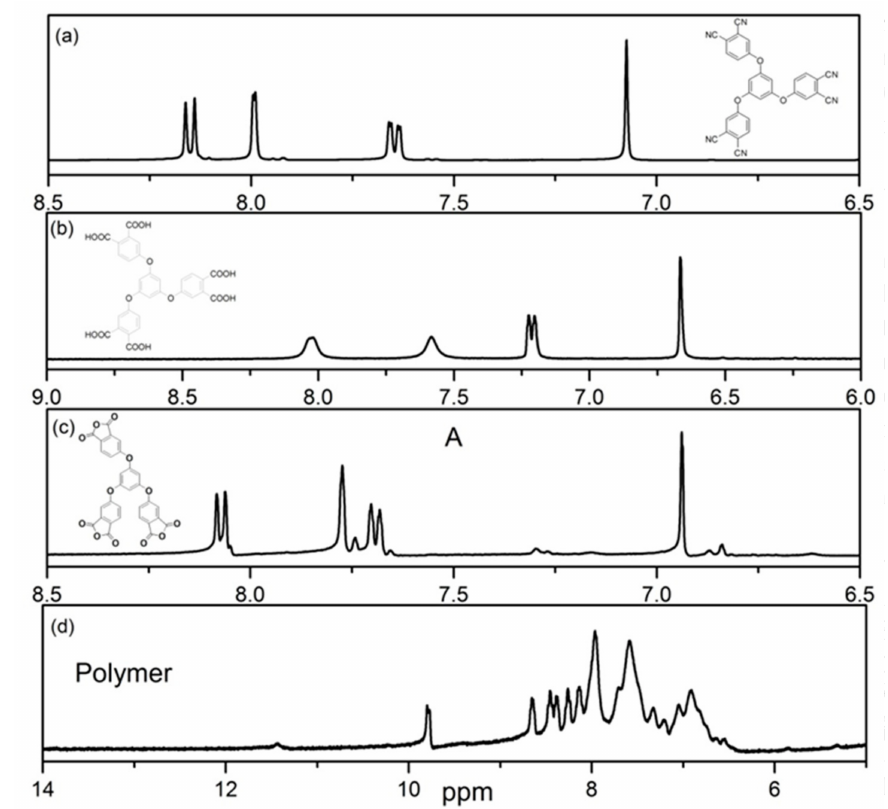
Figure 1. 1 H NMR spectra of the intermediate product ( a – c ) and the sulfonated polyimide ( s -PI) polymer ( d